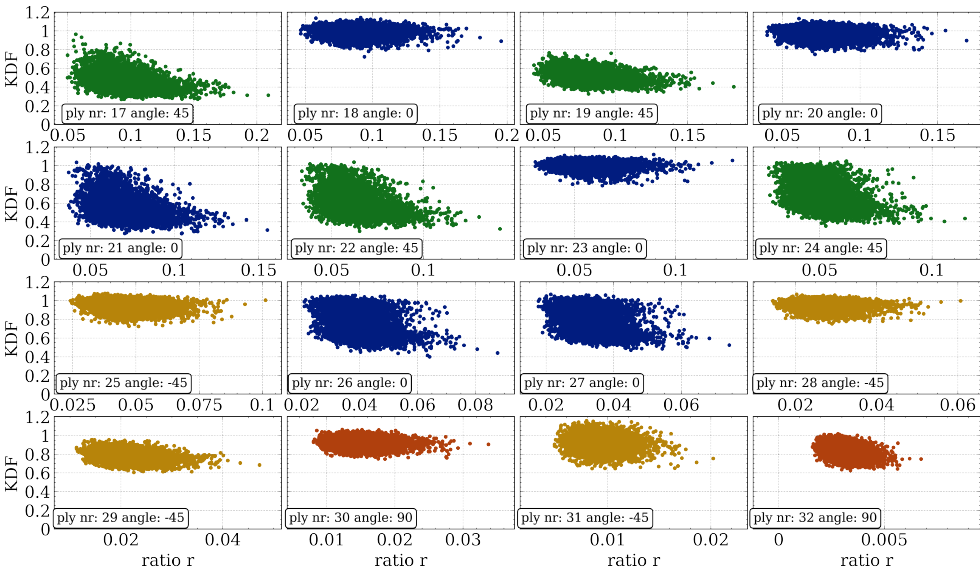
Figure 16. Scatter plot of maximum curvature in fiber orientation direction compared to resulting KDF for R x . Plies that share the same fiber orientation angle are colored equally.